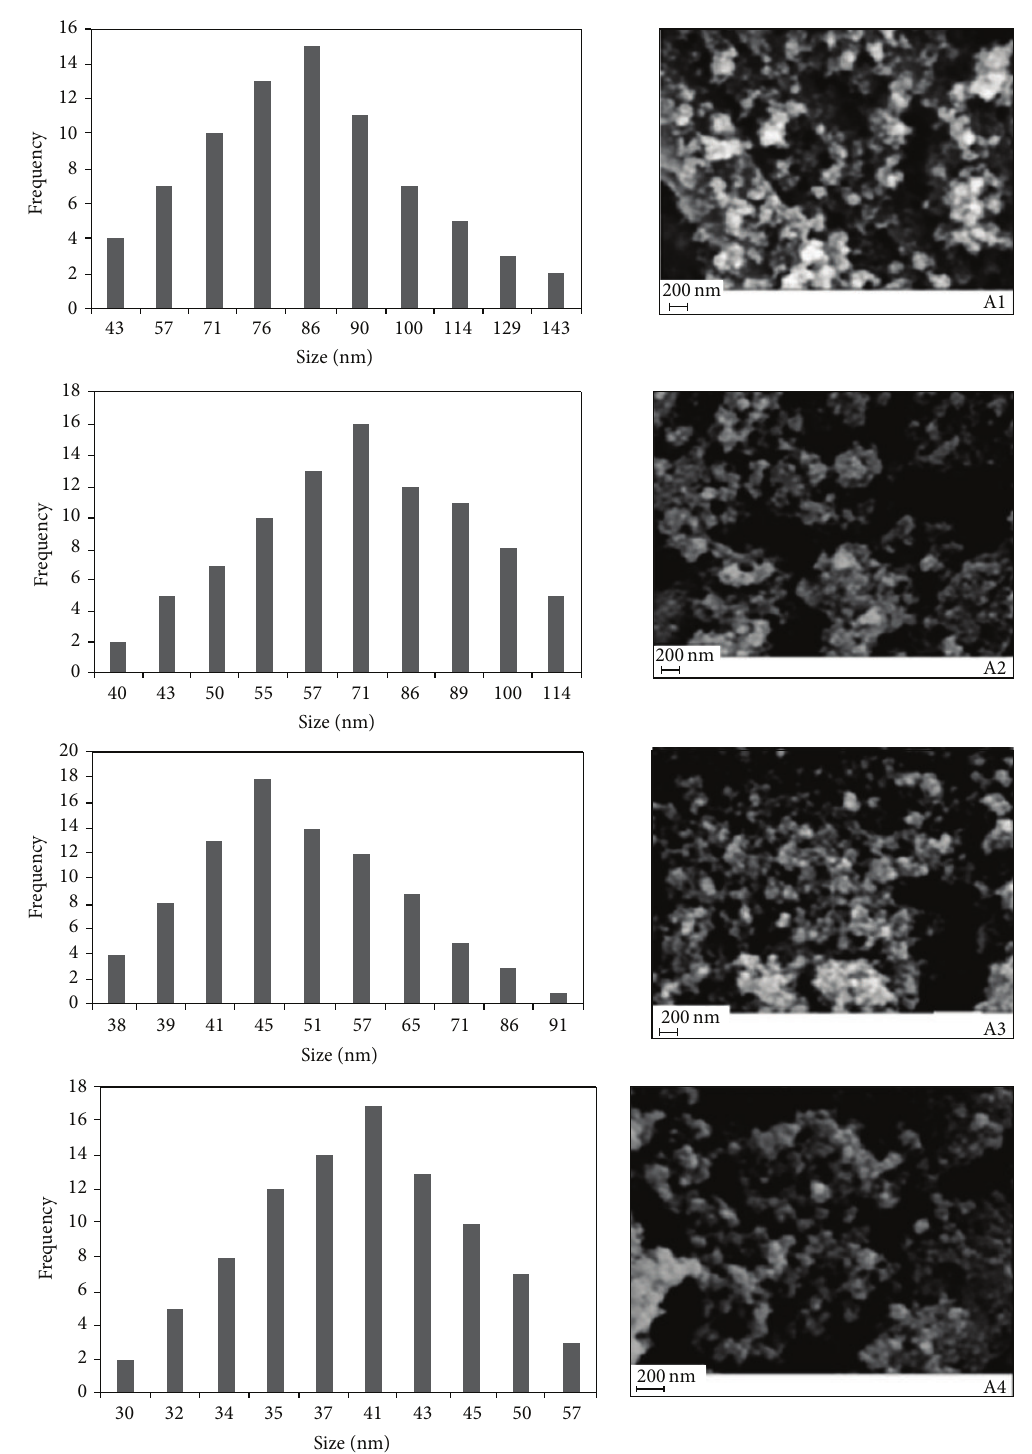
Figure 5: Scanning electron microscopic photographs of Fe 3 O 4 nanoparticles prepared at different temperatures: (A1) 273 K; (A2) 283 K; A3) 293 K; and (A4) 303 K, and their particle size